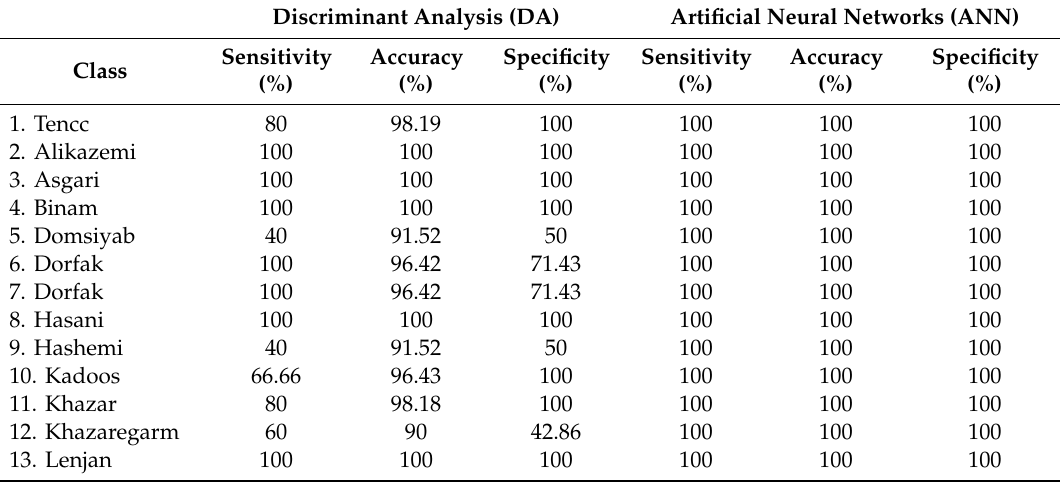
Table 6. Performance criteria for the two classifiers in the classification of white rice